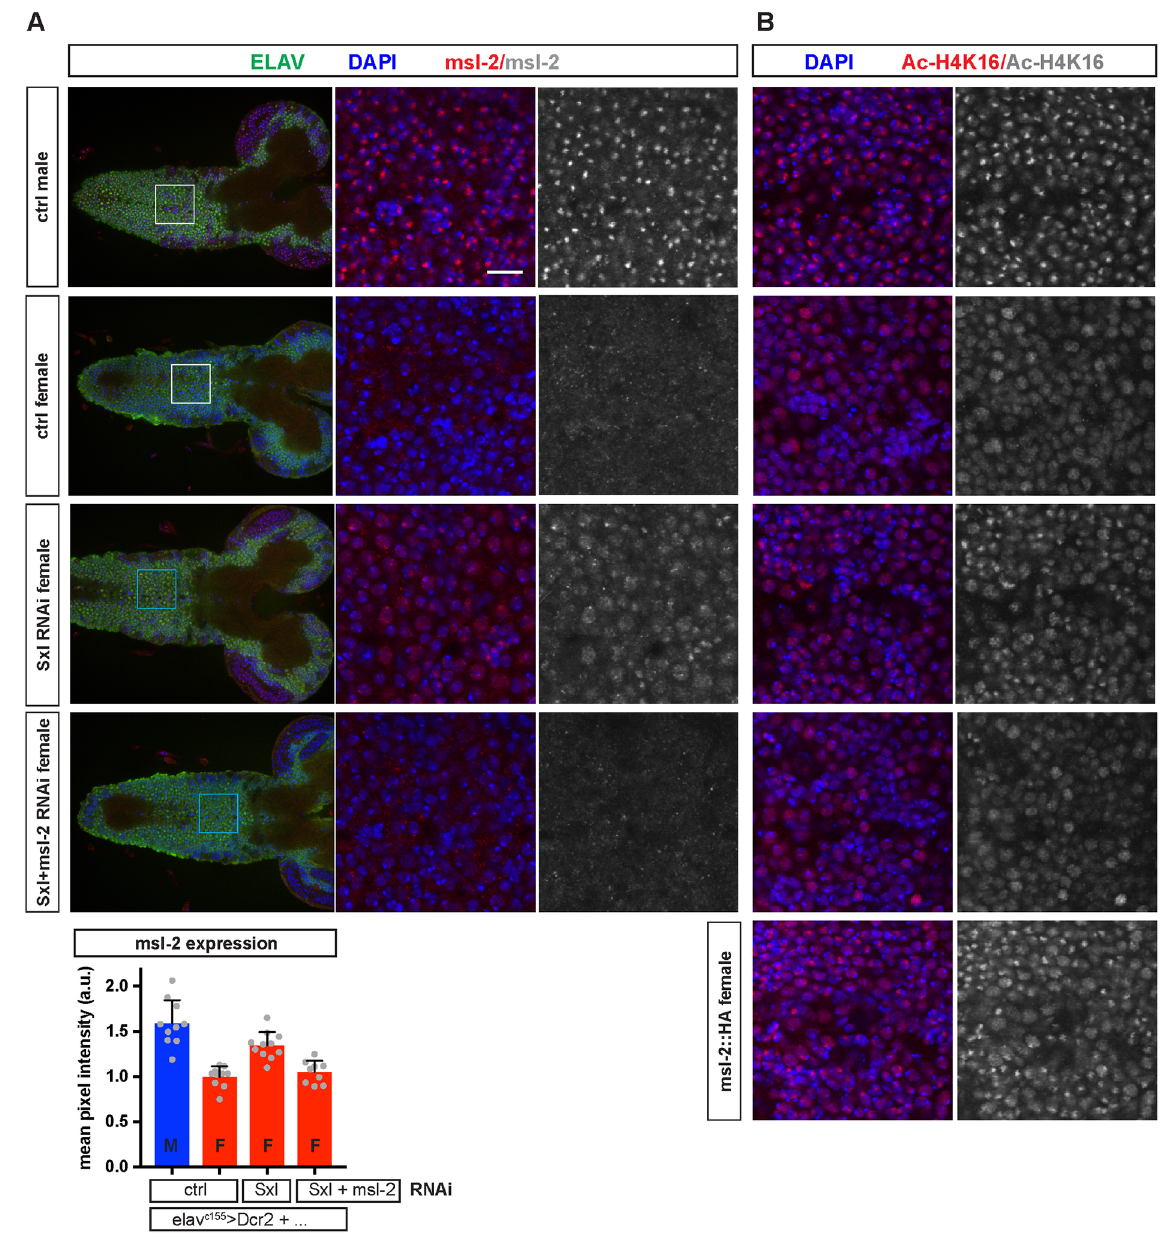
Fig 4. Male-specific lethal 2 ( msl-2 ) knockdown blocks expression of Msl-2 and acetylatedhistone H4 lys16 (H4K16)in elav c155 > Sxl RNAi females. (A) Expression of Msl-2 and Elav (a neuronalmarker) with DNA stainedby DAPI in central nervous systems (CNSs) from early L3 larvae of the indicatedsex and genotype. Left panelsshow single confocalsections close to the neuropil,where functionalneurons, not immature postembryonic neurons, predominate. Centre and right panels show higher magnification views of boxed regionsin the left panels.Msl-2 in control males localisesto nuclear foci, consistent with its X chromosome localisation, and it is weak/absent in control females. In elav c155 > Dcr2 + Sxl RNAi 1 + msl-2 RNAi females, Msl-2 is expressedat moderate levels, and this ectopic Msl-2 is suppressed in elav c155 > Dcr2 + Sxl RNAi 1 females. Bottom graph shows quantification of Msl-2 expression(mean fluorescence intensity) measuredin a regionof interest similar to the boxed regions.Note that mean fluorescence intensity levels in control female levels likely reflect background signal. (B) Expression of histoneH4 acetylatedat lysine 16 (Ac-H4K16) with DNA stainedby DAPI in CNSs from early L3 larvae of the indicatedsex and genotype. Left and right panelsshow high magnification views from similar regionsof the CNS as shown in A. Ac-H4K16 in control males strongly localisesto nuclearfoci (the X chromosome) and, in both sexes, lower signal intensity is observedthroughoutthe nucleus (autosomes). Ac-H4K16 nuclearfoci are observedin elav c155 > Dcr2 + msl-2 :: HA and elav c155 > Dcr2 + Sxl RNAi 1 females but not in elav c155 > Dcr2 + Sxl RNAi 1 + msl-2 RNAi females. The underlyingdata for this figure can be found in S1